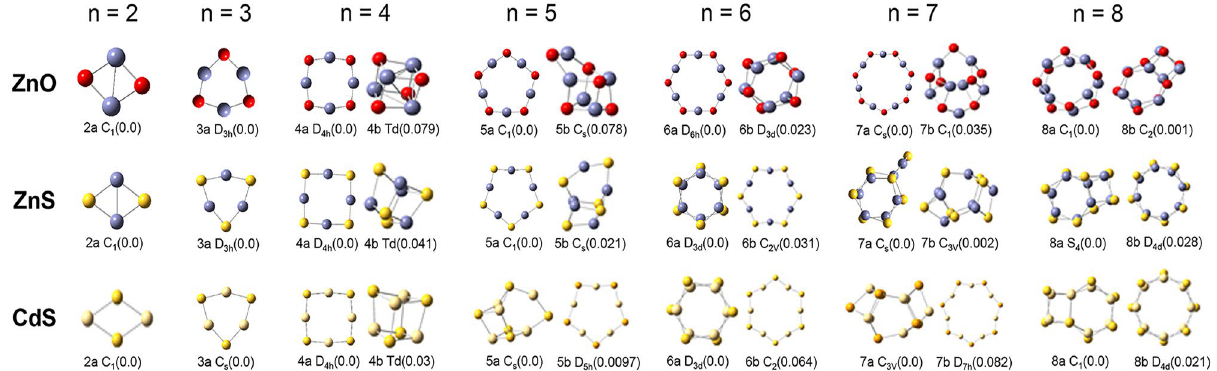
Figure 4. Optimized structures of Zn n O n , Zn n S n , and Cd n S n , n = 2–8 at the lowest/lower energy states. The energy from low to high is labeled by a and b. The values in the brackets are the energy difference to the lowest energy state of the corresponding structure.